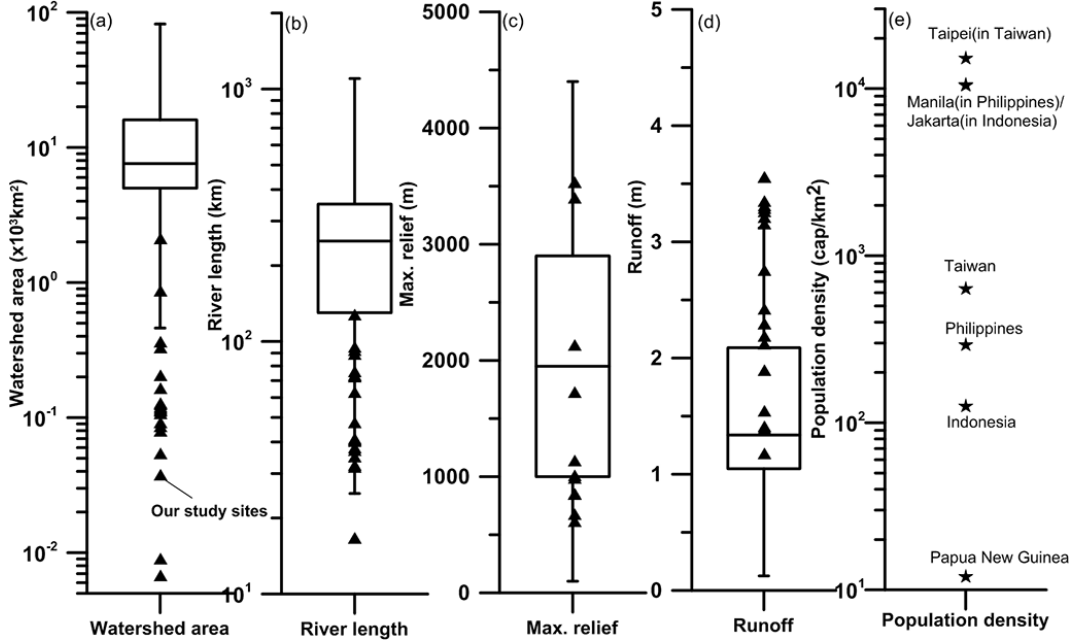
Figure 8. The spectra of characterized parameters, (a) watershed area, (b) river length, (c) maximum relief and (d) runoff, for Oceania rivers, and (e) population density in some Oceania countries and their cities (stars). The triangles represent our 20